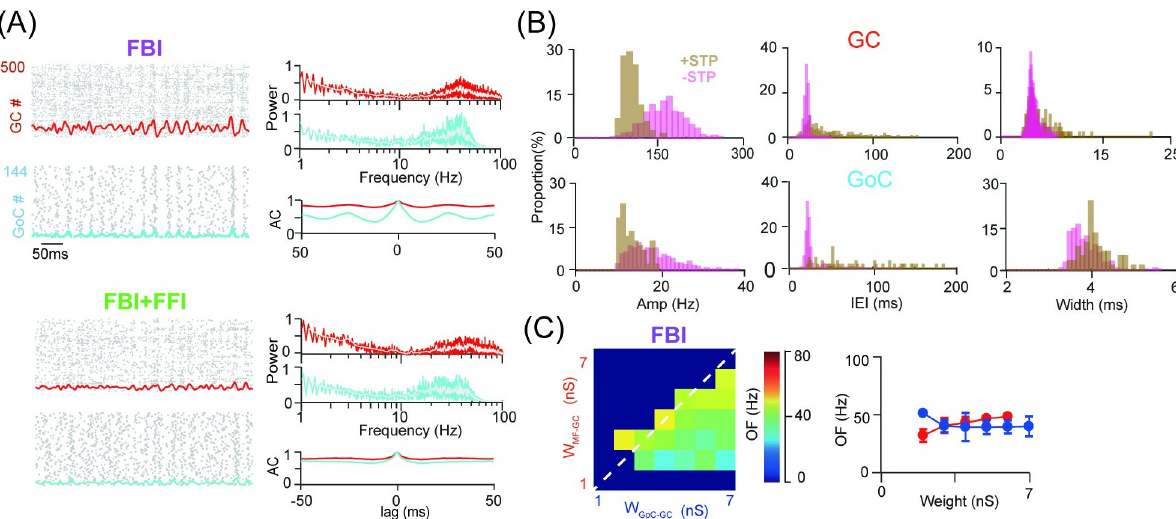
Fig 3. Oscillation suppressed by short-term plasticity of GoC-GC synapses. (A) Spike raster and population firing rate of all GCs and GoCs (left), and the corresponding power spectrum and auto-correlation (AC) of population firing rate (right) in two network scenarios of FBI (top) and FBI+FFI (bottom). Here short-term plasticity (STP) of GoC-GC synapses was included. (B) Oscillation metrics characterized by the amplitude (Amp), inter- event interval (IEI) and width. Histograms of three metrics for GCs (top) and GoCs (bottom) with STP (+STP) and without STP (-STP). (C) Modulation of the oscillation frequency (OF) over increasing W MF and W GoC strengths in networks with FBI. The point marked as white the − GC − GC left plot is the default values W MF − GC = 3 nS and W GoC − GC = 4 nS fixed for showing the monotonic change on the right plot.